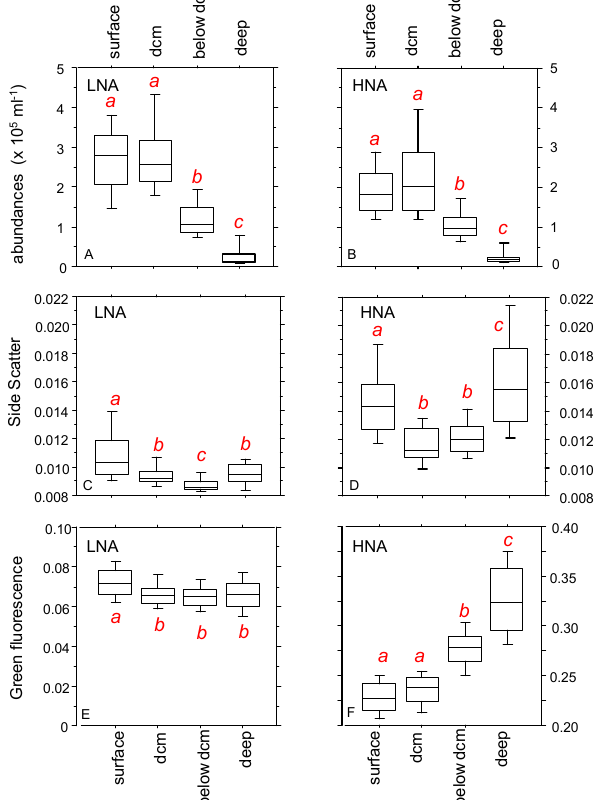
Fig. 4. Box plots showing distribution of ( A, B) : abundances, (C, D) : side scatter and (E, F) : green fluorescence of subgroups LNA and HNA along different water column layers: above the deep chlorophyll maximum (“surface”), at the deep chlorophyll maxi- mum (“dcm”), below the dcm but above or equal to 250m (“below dcm”), and below 250m (“deep”). Groups connected by the same letter (in italics and in red) are not significantly different at the 0.01 probability level. Lower to the upper values are indicated, respec- tively, 10%, 25%, 50% (median), 75 and 90% percentiles.